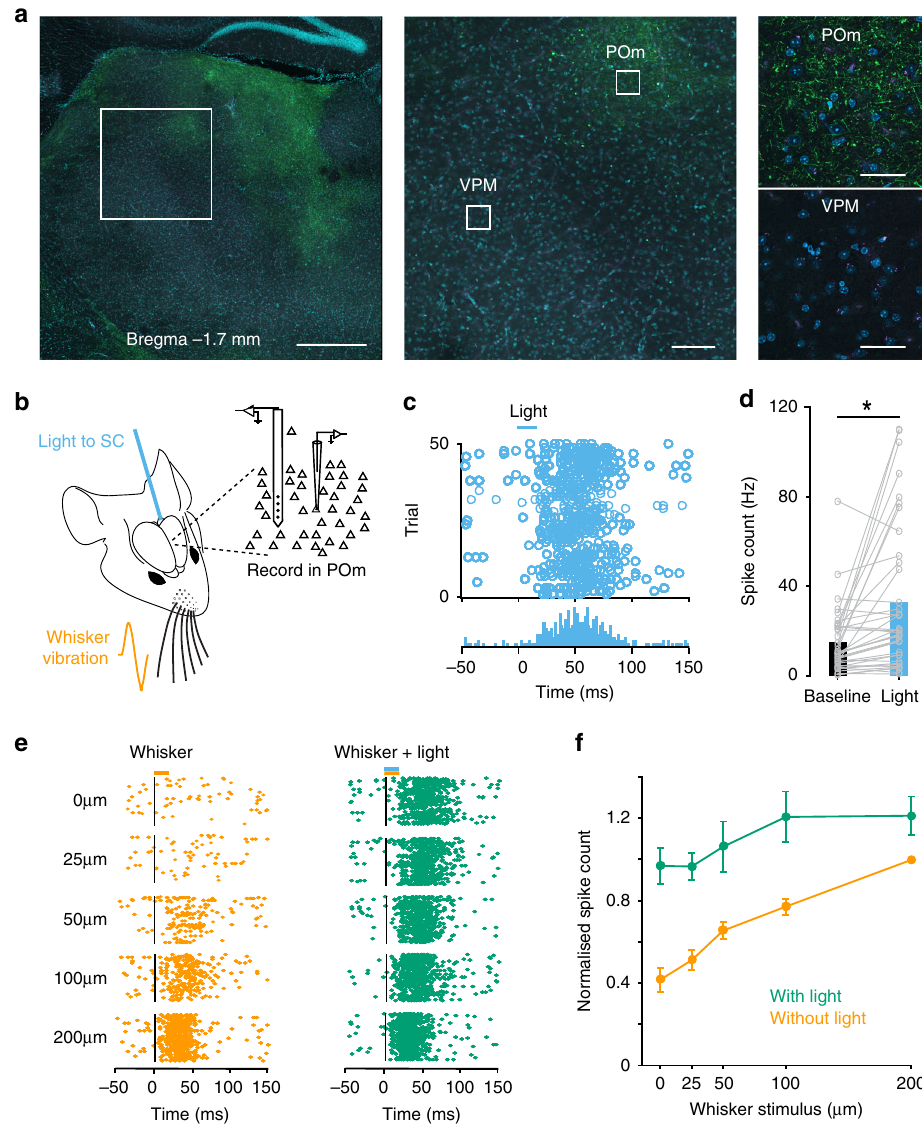
Fig. 4 Activation of SC drives activity in POm. a Left: coronal section of thalamus showing SC axons (in green) in POm. Scale bar 500 µ m. DAPI in blue. Middle: somatosensory thalamus showing the region delineated by the white square in the left image. Scale bar 100 µ m. Right: higher magni fi cation of the regions delineated by the white squares in the middle image showing SC axons in POm but not VPM. Scale bars 40 µ m. b Schematic of the experimental arrangement. After cutting the facial nerves, recordings were made from the POm while activating SC optogenetically through an optic fi ber in the presence or absence of whisker vibration. c Raster plot (top) and peri-stimulus time histogram (bottom) of an extracellular array recording from a POm neuron (2407 µ m from the surface of the brain) showing increased action potential fi ring in response to SC activation. d Spiking of POm neurons ( n = 38) increases signi fi cantly during light activation of SC. Asterisk represents p < 0.001 (Two-sided paired t -test). e Raster plot of action potential fi ring in a POm neuron (same neuron as c ) during whisker movement of different amplitude alone (orange; left) and with light activation of SC (green; right). f Pooled data showing the impact of SC activation (green) on the whisker input – output relationship of whisker responsive POm neurons (orange). Only neurons that were responsive to both whisker and SC stimulation were included in this analysis ( n = 15). Spiking of each neuron was normalized to the maximum response to whisker stimulation alone. Error bars represent SEM. Source data are provided as a Source Data fi